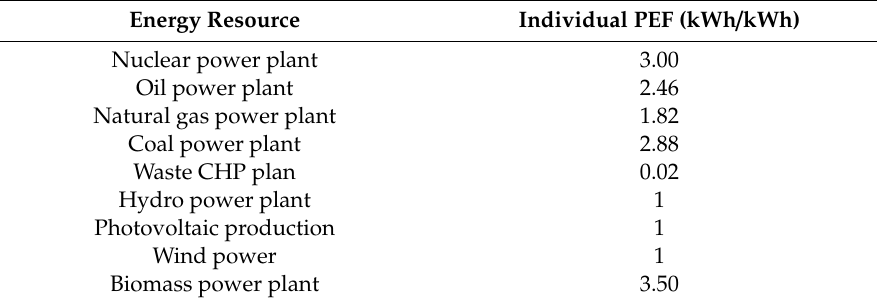
Table 4. Calculated individual primary energy factors (PEF) for di ff erent energy resources.